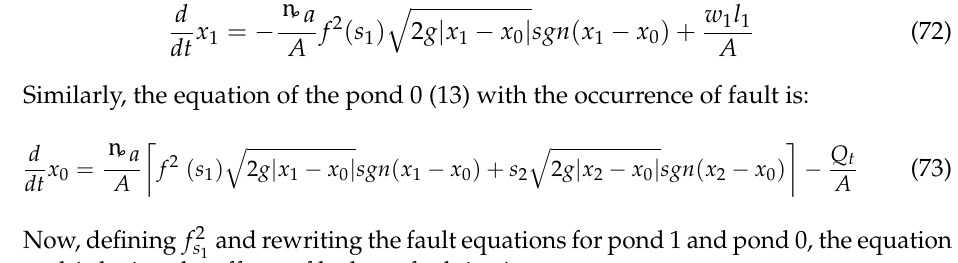
Figure 1. Three-pond hydraulic system.